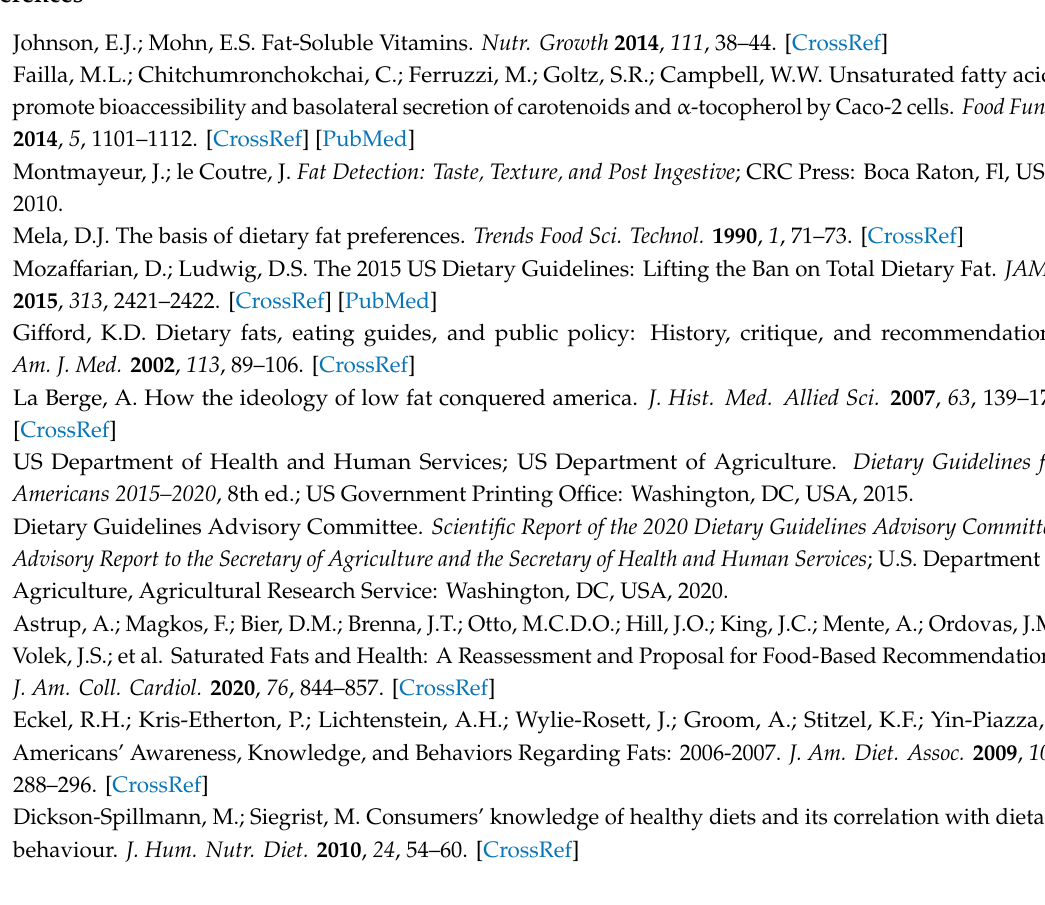
Figure S1: The Principles of Healthy, Sustainable Menus; Table S1: Characteristics of schools participating in the Faith in Fat and Love It or Lose It studies; Table S2: Frequency of fat option choice by sex in the Faith in Fat study; Table S3: Frequency of fat option choice by school in the Faith in Fat study; Table S4: Frequency of fat option choice by year classification in the Faith in Fat